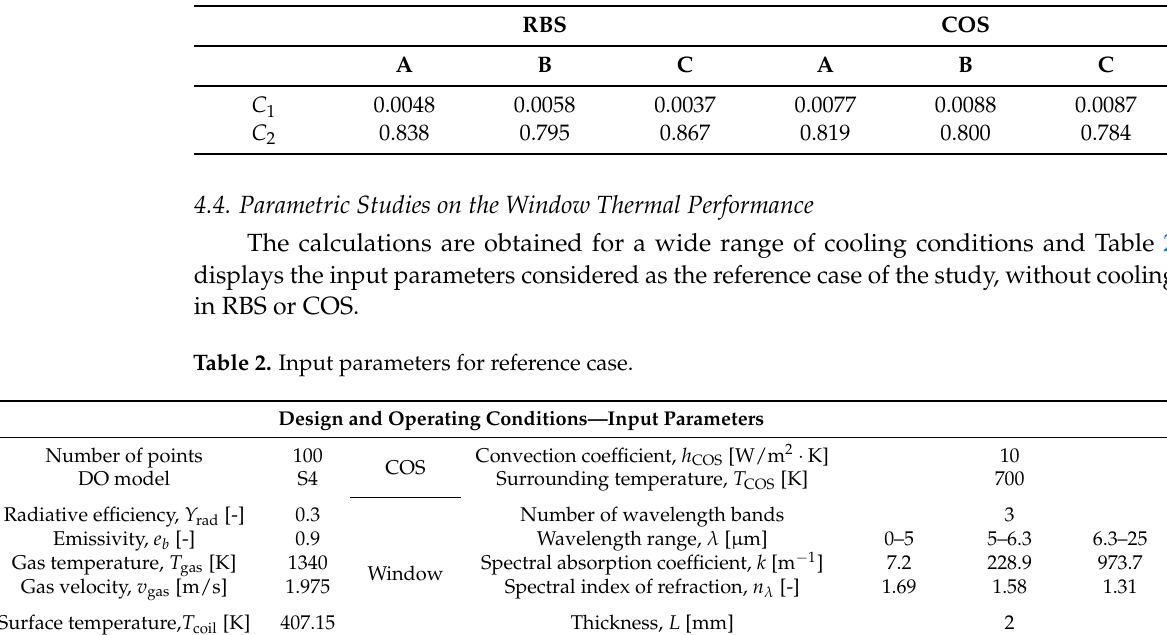
Table 1. Coefficients for heat transfer correlation.